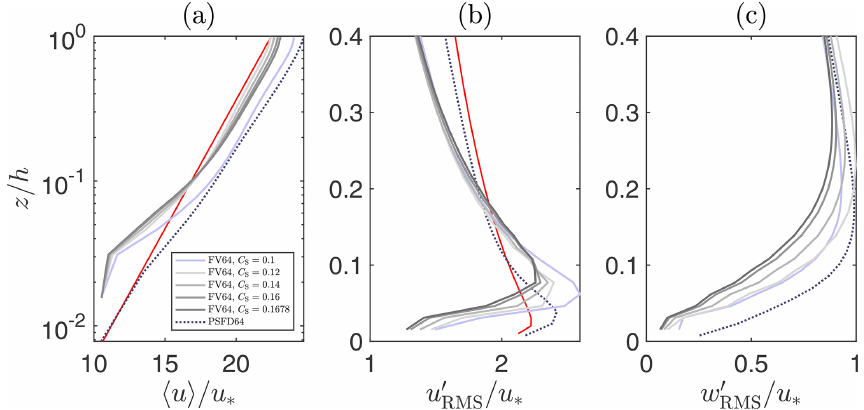
Figure A1. Vertical structure of streamwise velocity (a) , streamwise velocity RMS (b) , and vertical velocity RMS (c) . Red lines denote the phenomenological logarithmic-layer profile (a) and analytical expressions from similarity theory (Stull, 1988) (b, c) .